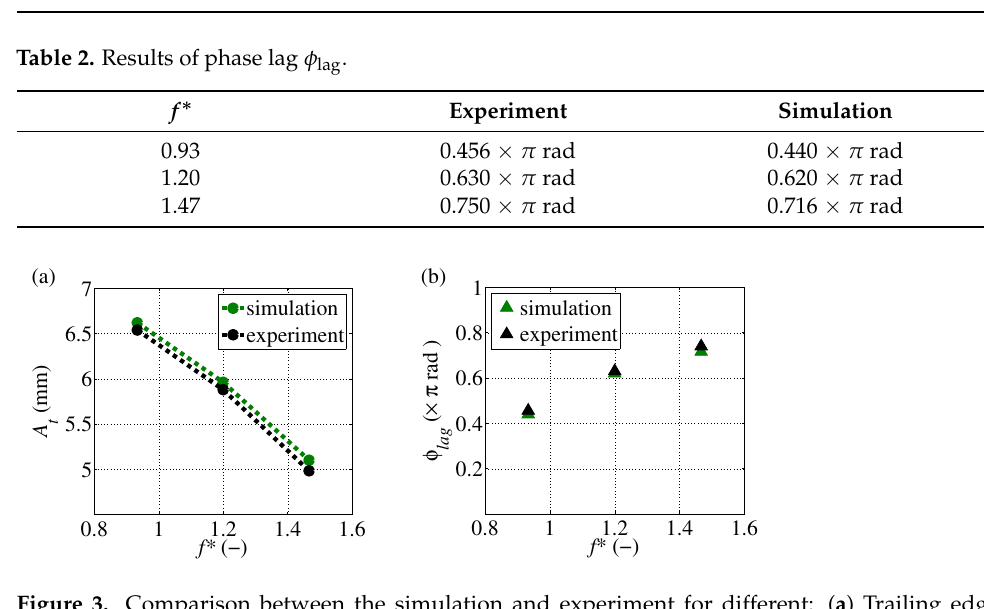
Figure 3. Comparison between the simulation and experiment for different: ( a ) Trailing edge amplitude A t . ( b ) Phase lag of the plate φ lag